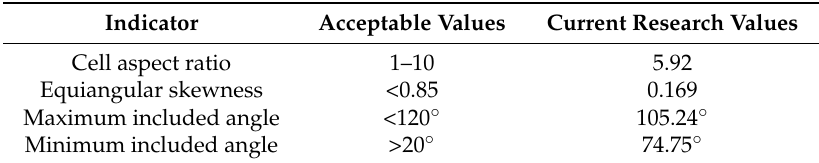
Table 2. Quality meshing parameters.